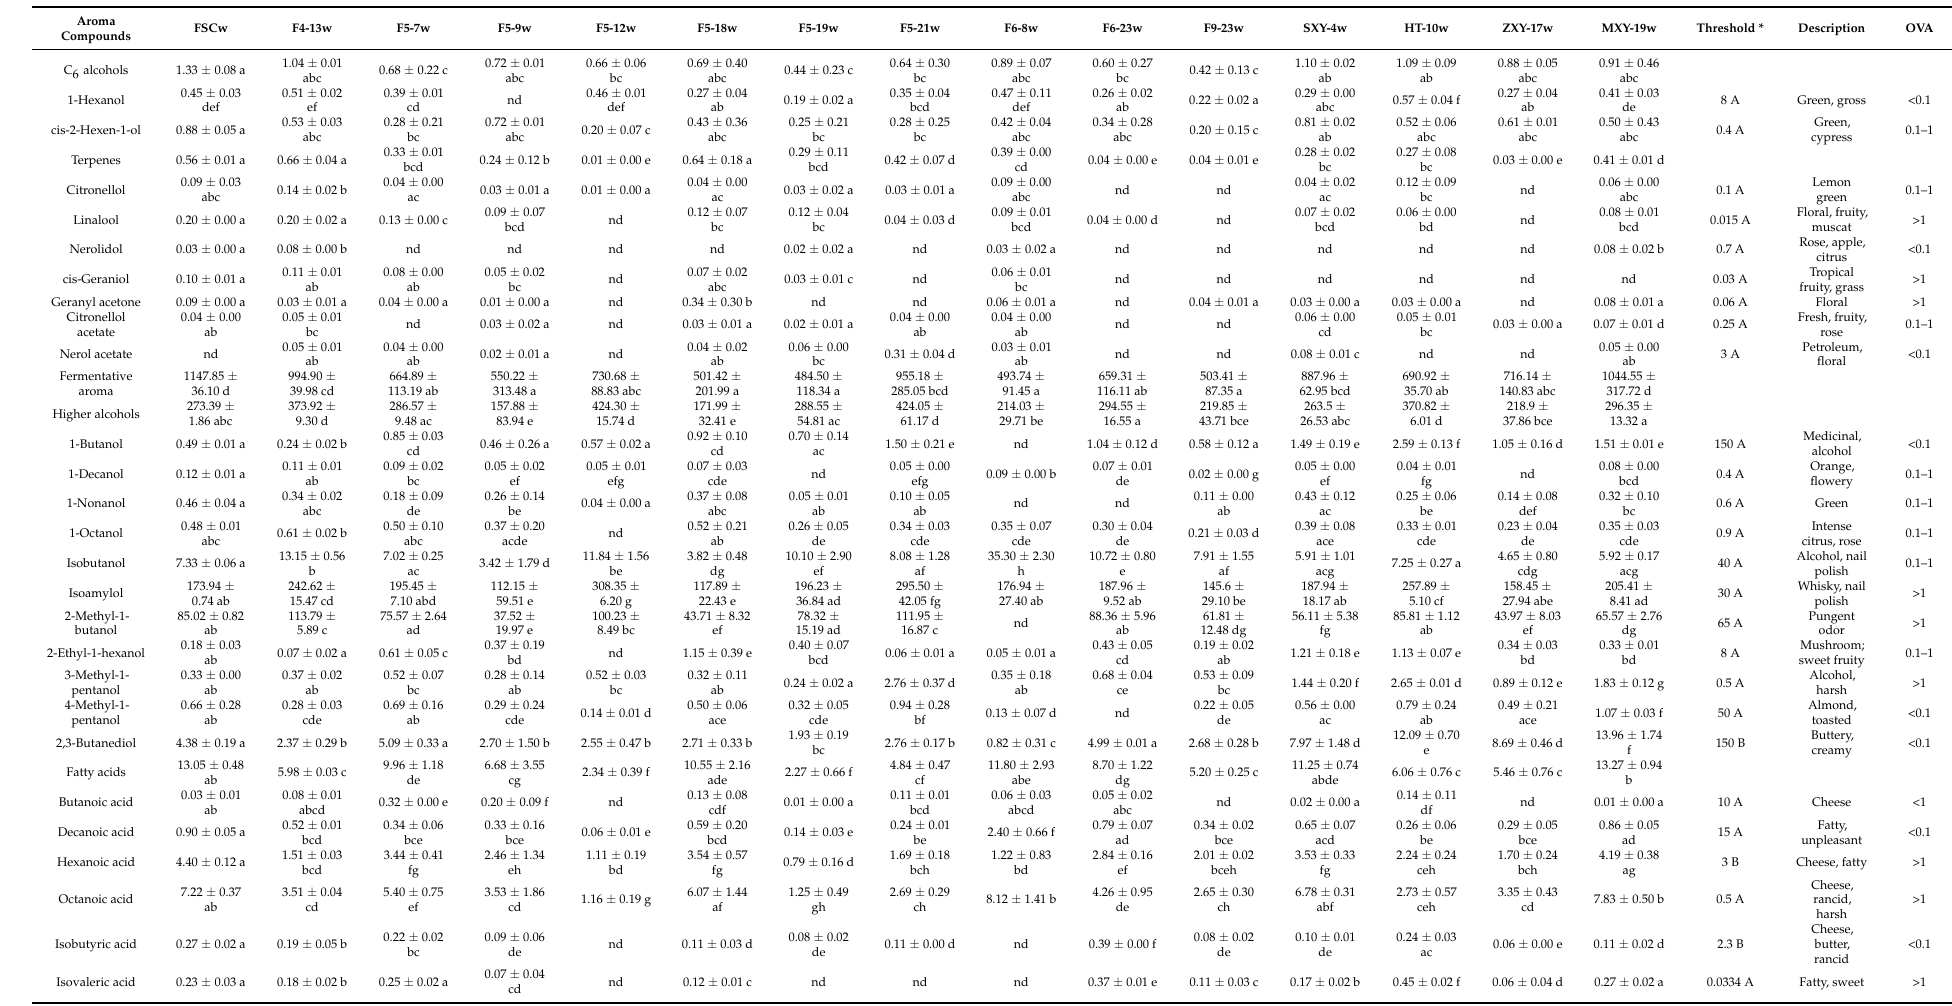
Table 2. Analysis of volatile aroma compounds in wines fermented by the selected S. cerevisiae strains (mg/L; means ±